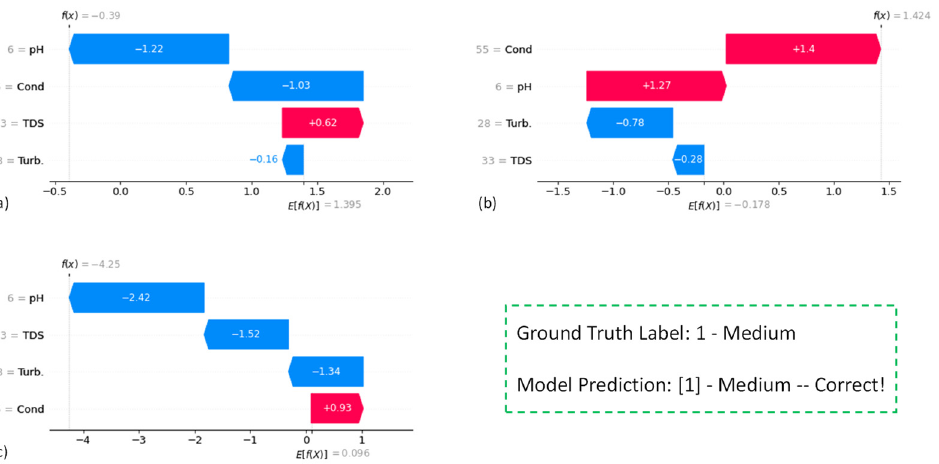
Figure 13. Local interpretations of a correct prediction considering the various possibilities of occurrence for different As concentrations: ( a ) low; ( b ) medium; and ( c ) high.